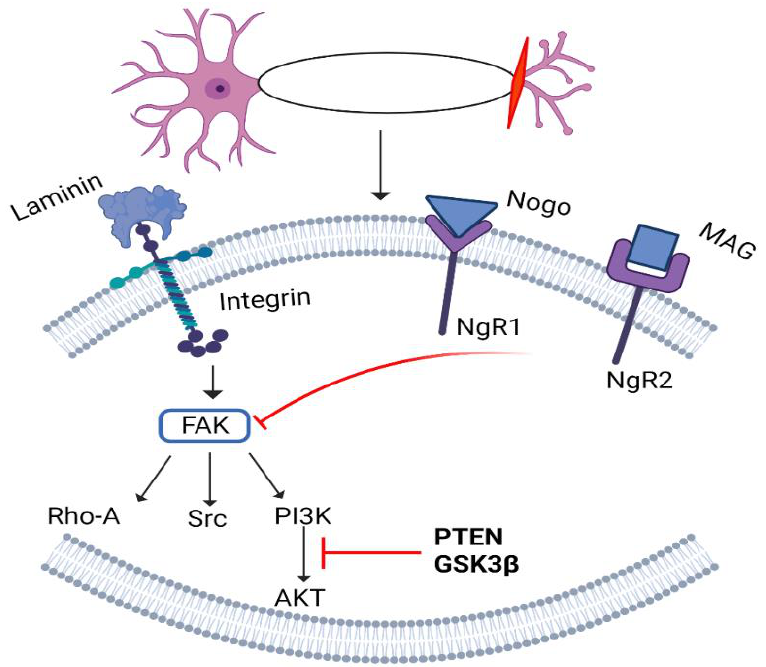
Figure 11. Integrin/FAK pathway. After nerve damage, integrin binds to different extracellular matrix ligands to activate FAK and PI3K/AKT, and Src. At the same time, Nogo and MAG not only bind to their respective receptors but also interfere with integrin to prevent activation of FAK. FAK: focal adhesion kinase; PI3K: phosphatidylinositol-3-kinase; PTEN: phosphatase and tensin homolog; AKT: protein kinase B; Gsk3 β : glycogen synthase kinase; MAG: myelin-associated glycoproteins; NgR: Nogo receptor; Rho-A/Src: protein.